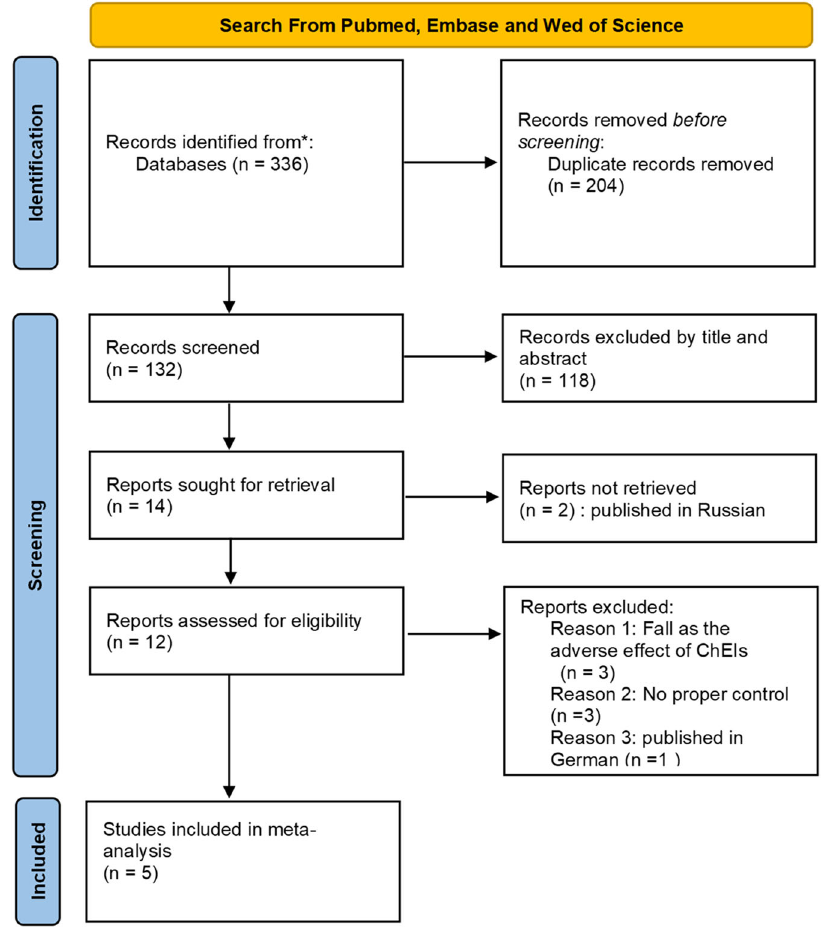
Fig. 1 The study selection fl owchart. Randomized controlled trials published before May 2021 in the PubMed, Embase, and Web of Science databases were searched following the Preferred Reporting Items for Systematic Review and Meta-Analysis (PRISMA)